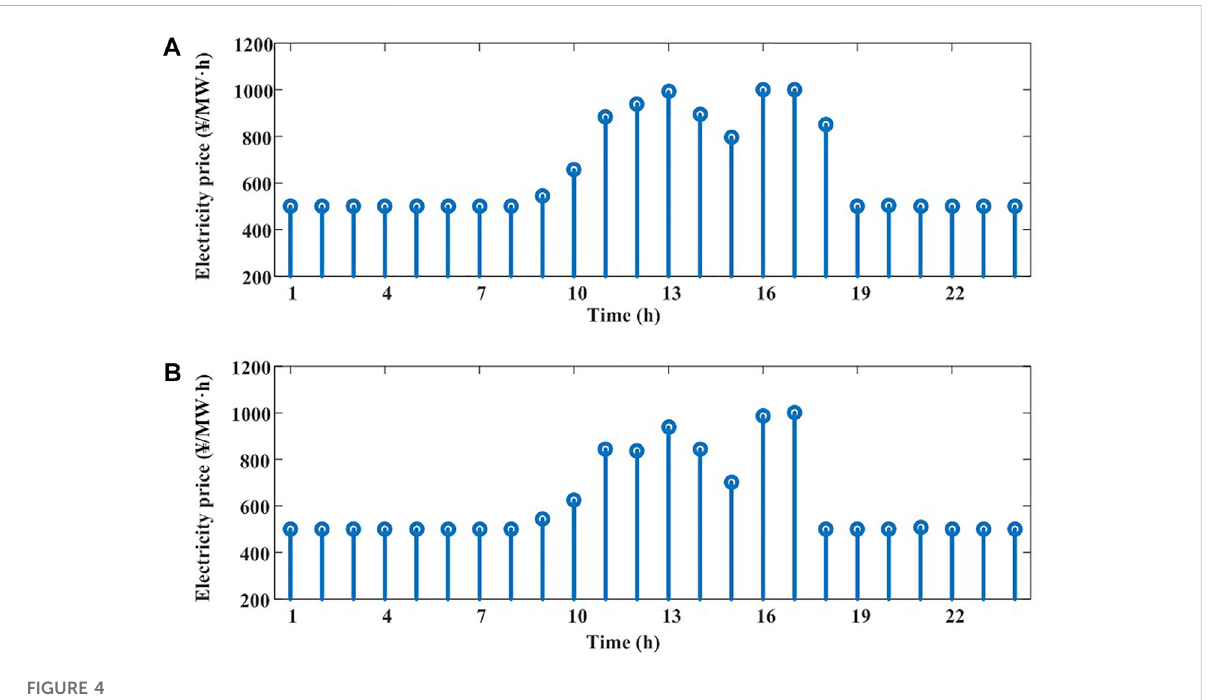
FIGURE 4 Electricity prices: (A) Γ wind = 0 (B) Γ wind =